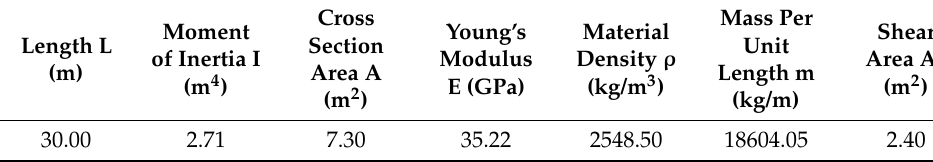
Table 1. Geometry and material properties of the simply supported beam.